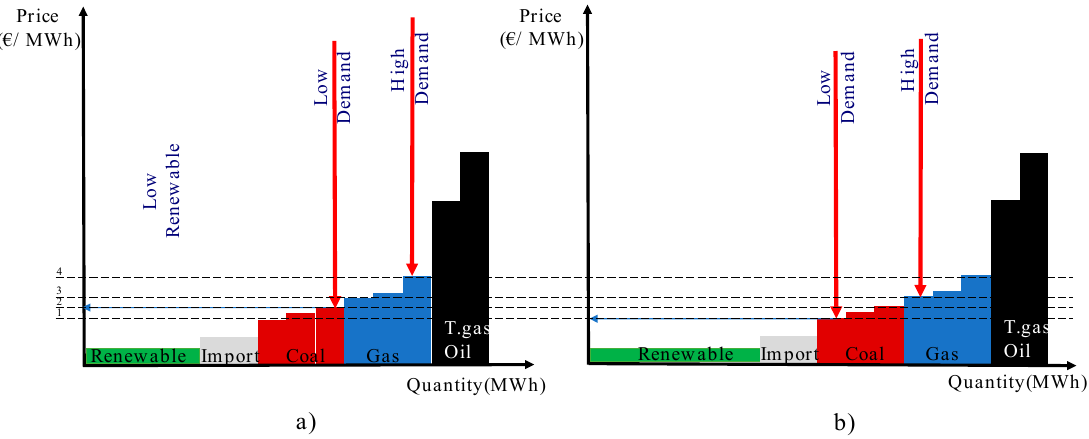
Figure 12. ( a ) dashed line 2: price with low demand / low RES, dashed line 4 price with high demand / low RES, ( b ) dashed line 1: price with low demand / high RES and dashed line 4: price with high demand / high RES.